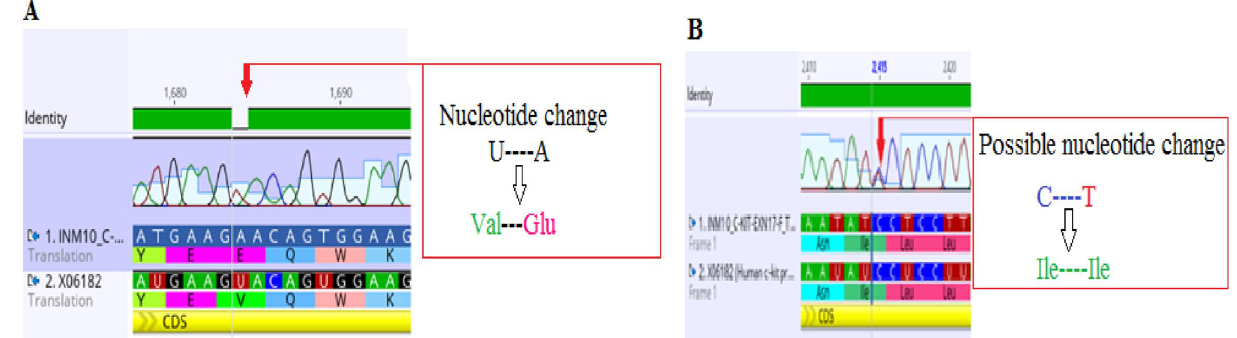
Figure 3. Electropherograms showing 1684 T > A substitution in exon 11 ( A ) and a heterozygous silent mutation 2415 C > T in exon 17 ( B ) when aligned to the reference sequence X06182.1. Both mutations were observed twice in different